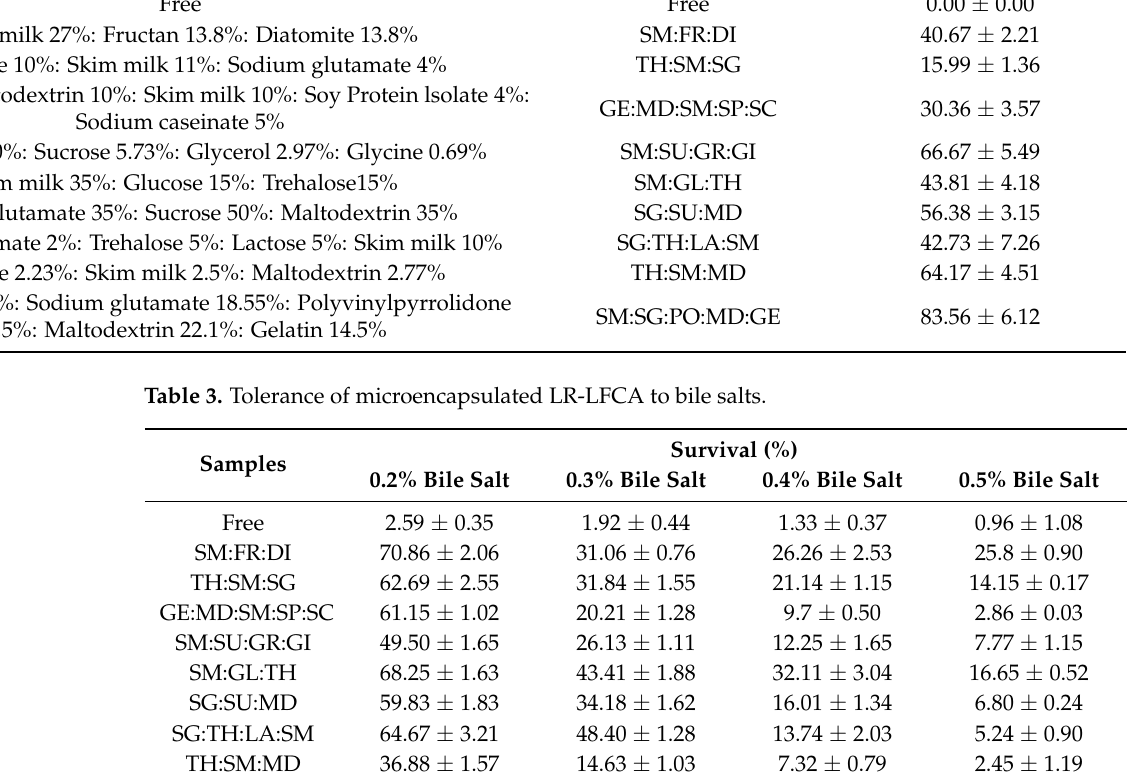
Table 2. Survival of microencapsulated LR-LFCA in different wall materials after spray drying. Wall Materials